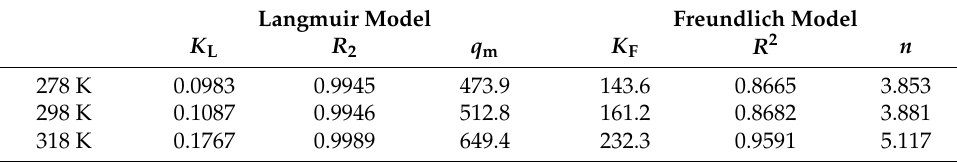
Table 2. Adsorption isotherm